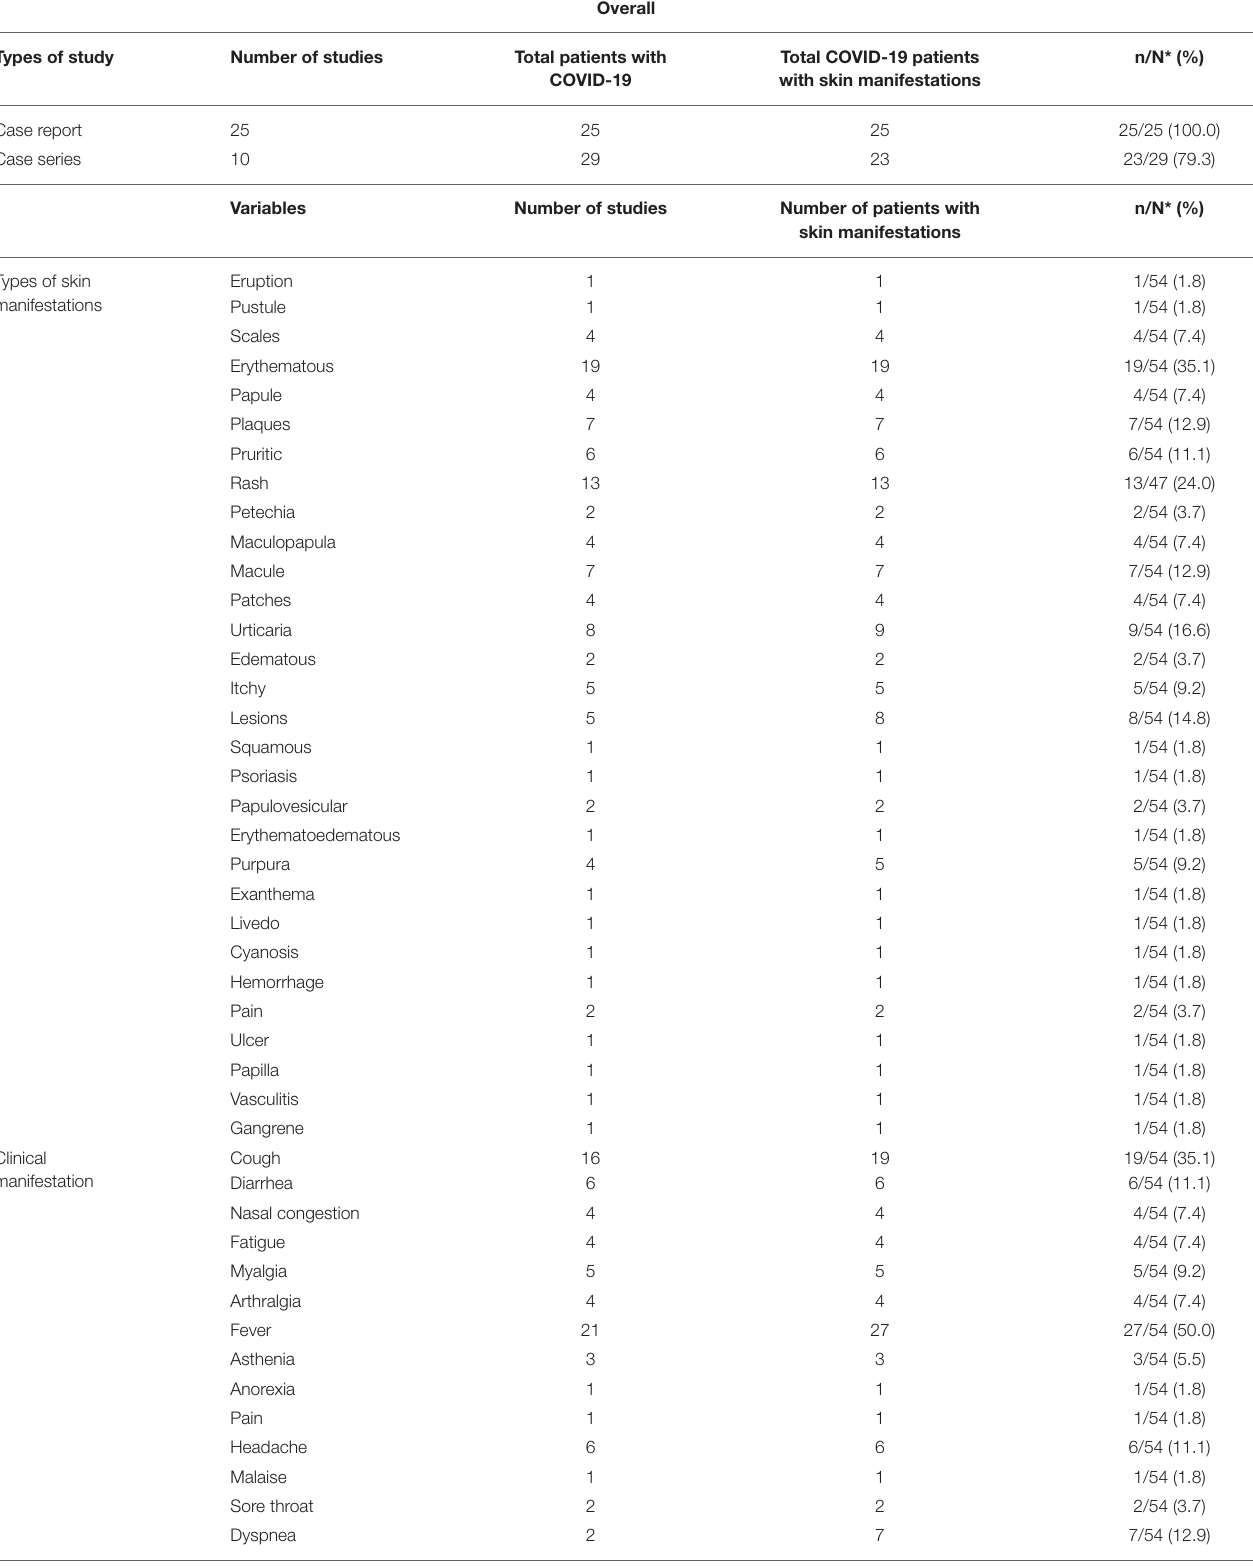
TABLE 4 | Summary of the case reports/case series